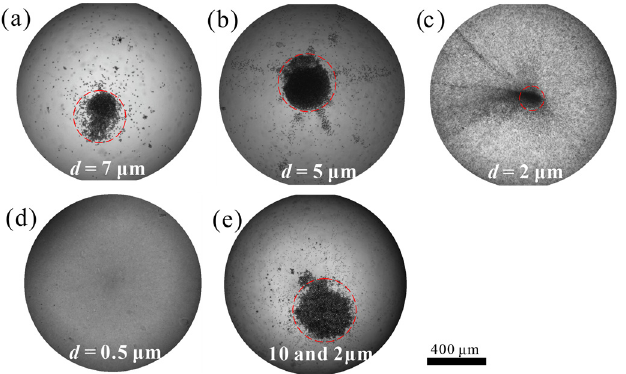
Figure 6. Particle concentration of different sizes within 300 s (48 kHz, 40 Vpp). ( a – d ) 7, 5, 2, and 0.5 µ m particle. Where d is particle diameter. ( e ) 10 and 2 µ m mixed particles. The images were taken at the h = 0. The equivalent diameter of the concentrated region for ( a – c , e ) are 352, 391, 167, and 429